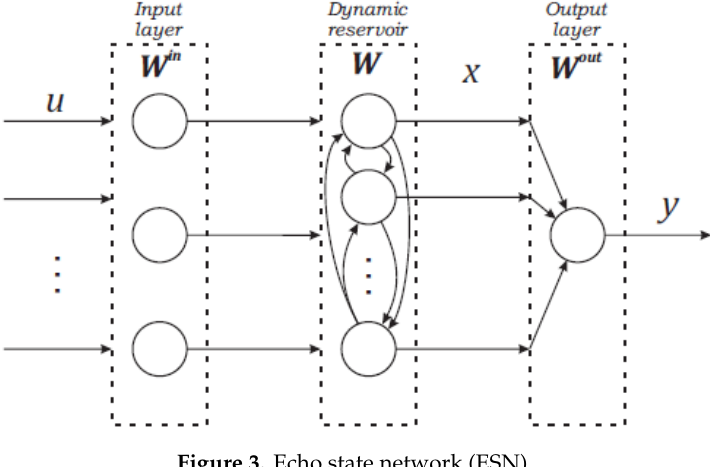
Figure 3. Echo state network (ESN).